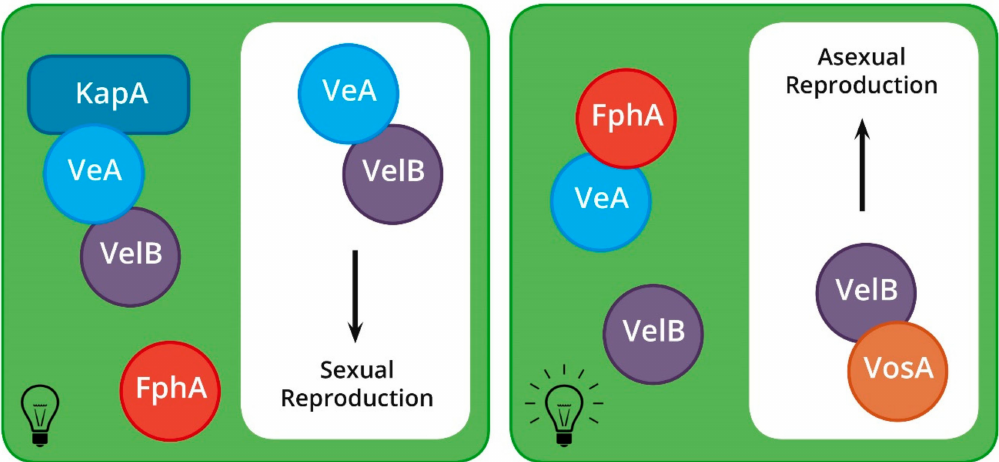
Figure 4. Sexual reproduction and light sensing in A. nidulans . Darkness: VeA and VelB interact with the importin protein, KapA. This allows their transport into the nucleus where they regulate gene expression and initiate sexual development. Light: FphA, the red light sensor, interacts with VeA, putatively inhibiting its interaction with KapA and VelB. This prevents the transport of VeA into the nucleus. Instead, VelB interacts with other proteins, activating asexual